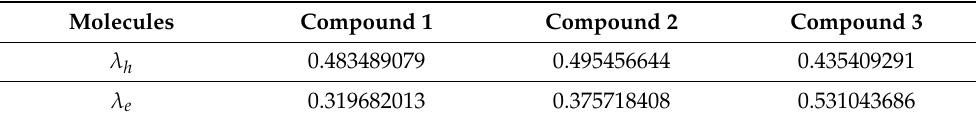
Table 6. The hole reorganization energies λ h (eV) and electron reorganization energies λ e (eV) of three investigated molecules.